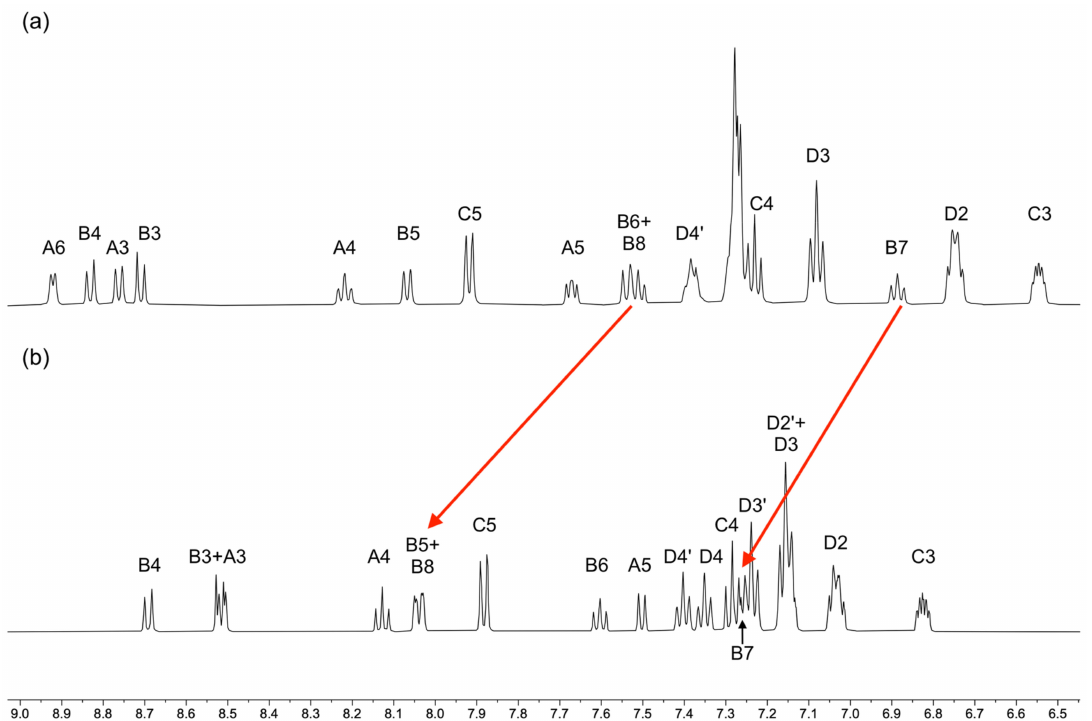
Figure 2. Comparison of the aromatic regions of the 1 H NMR spectra (500 MHz, acetone- d 6 , 298 K) of ( a ) [Cu(xantphos)( 1 )][PF 6 ] and ( b ) [Cu(xantphos)( 2 )][PF 6 ]. See Scheme 1 for atom labelling. Scale: δ / ppm. Note the movement of the signals for quinoline protons H B7 and H B8 (see text).